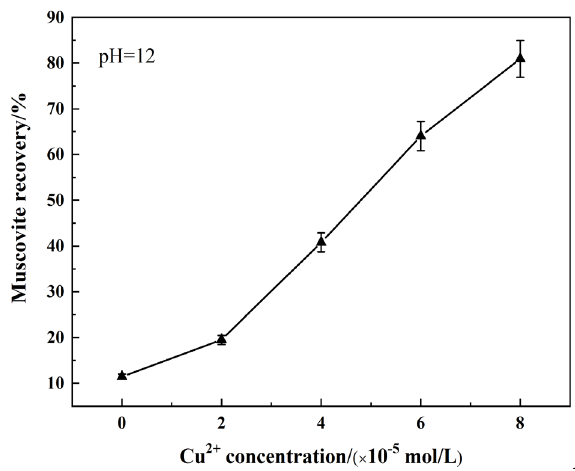
Figure 4. Effects of different concentrations of Cu 2+ on the recovery of muscovite (pH = 12, c (Sodium oleate) = 9.20 × 10 − 4 mol/L).